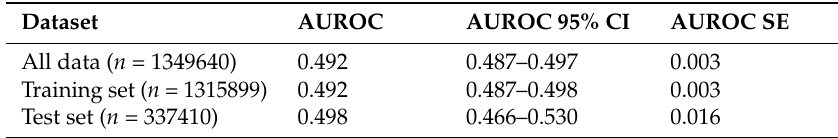
Table 4. The receiver operating characteristic of